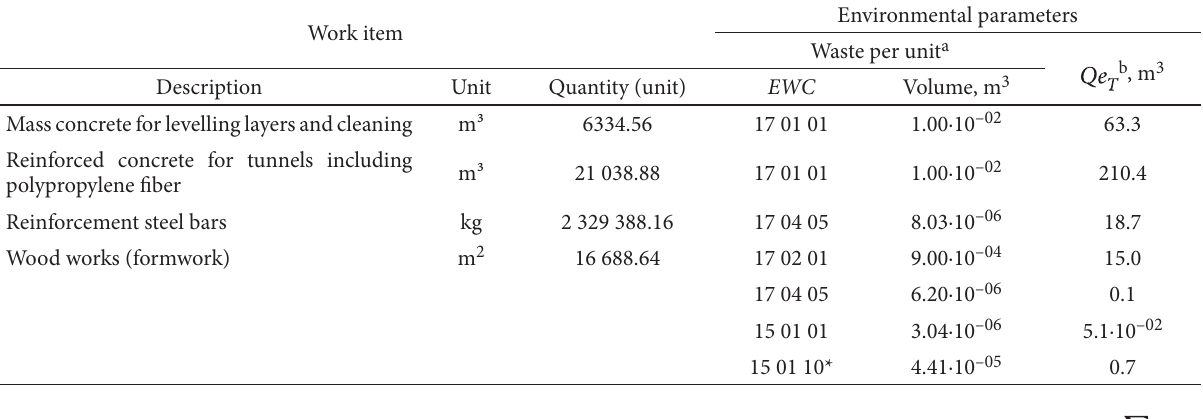
Table 2. Example of C&D waste quantification generated in the tunnel